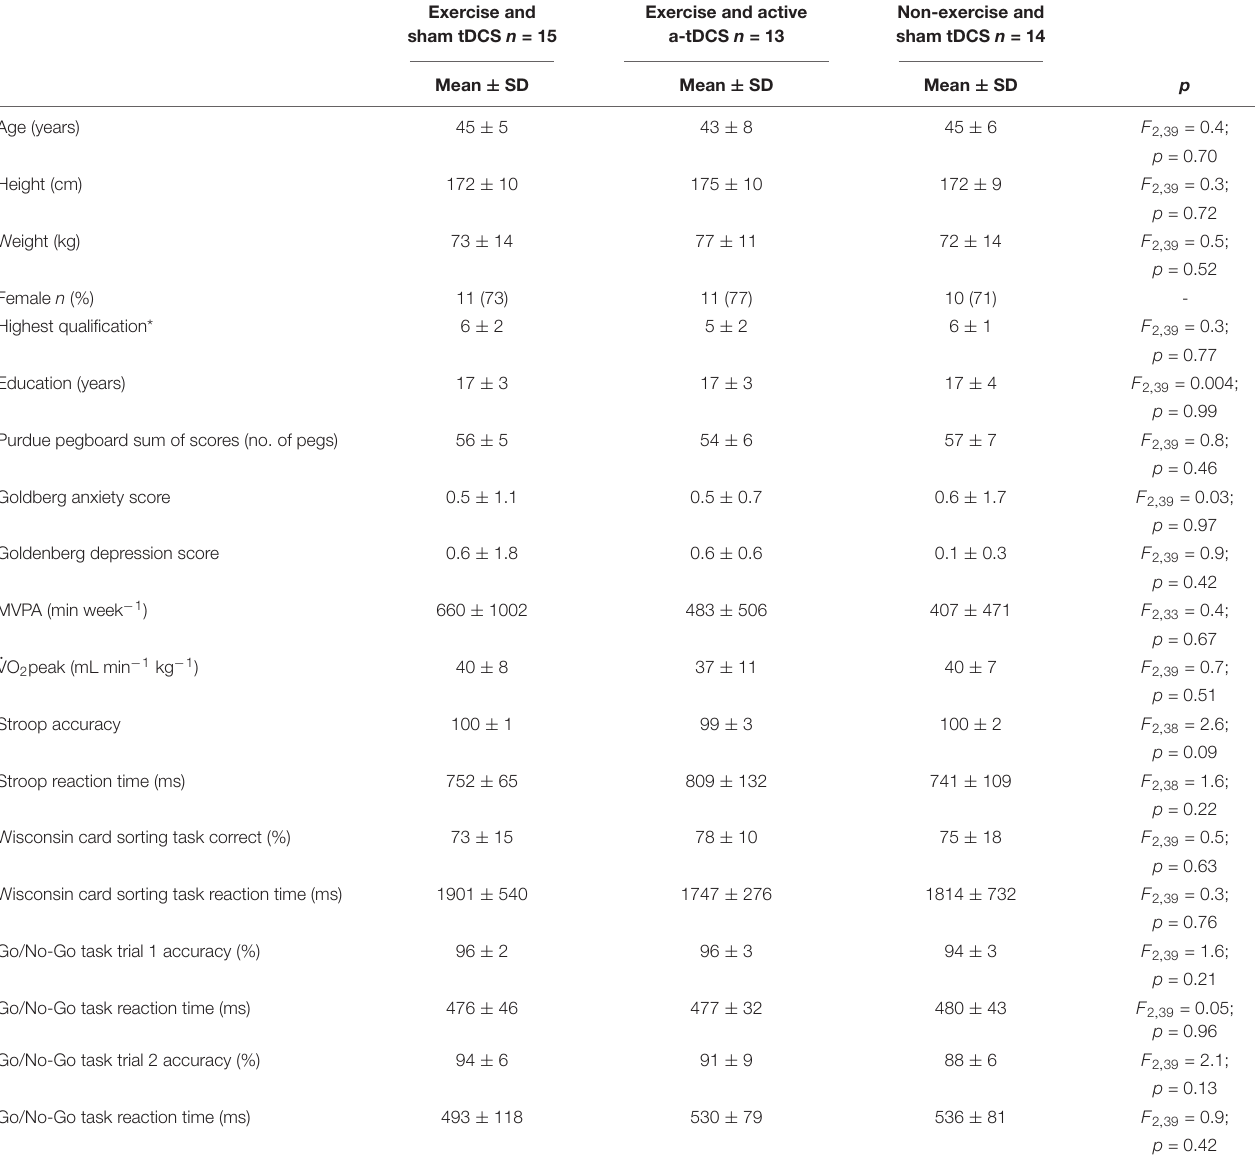
TABLE 1 | Group demographic, motor dexterity, self-reported mood, fitness, and cognitive performance characteristics and differences determined by one-way ANOVAs.